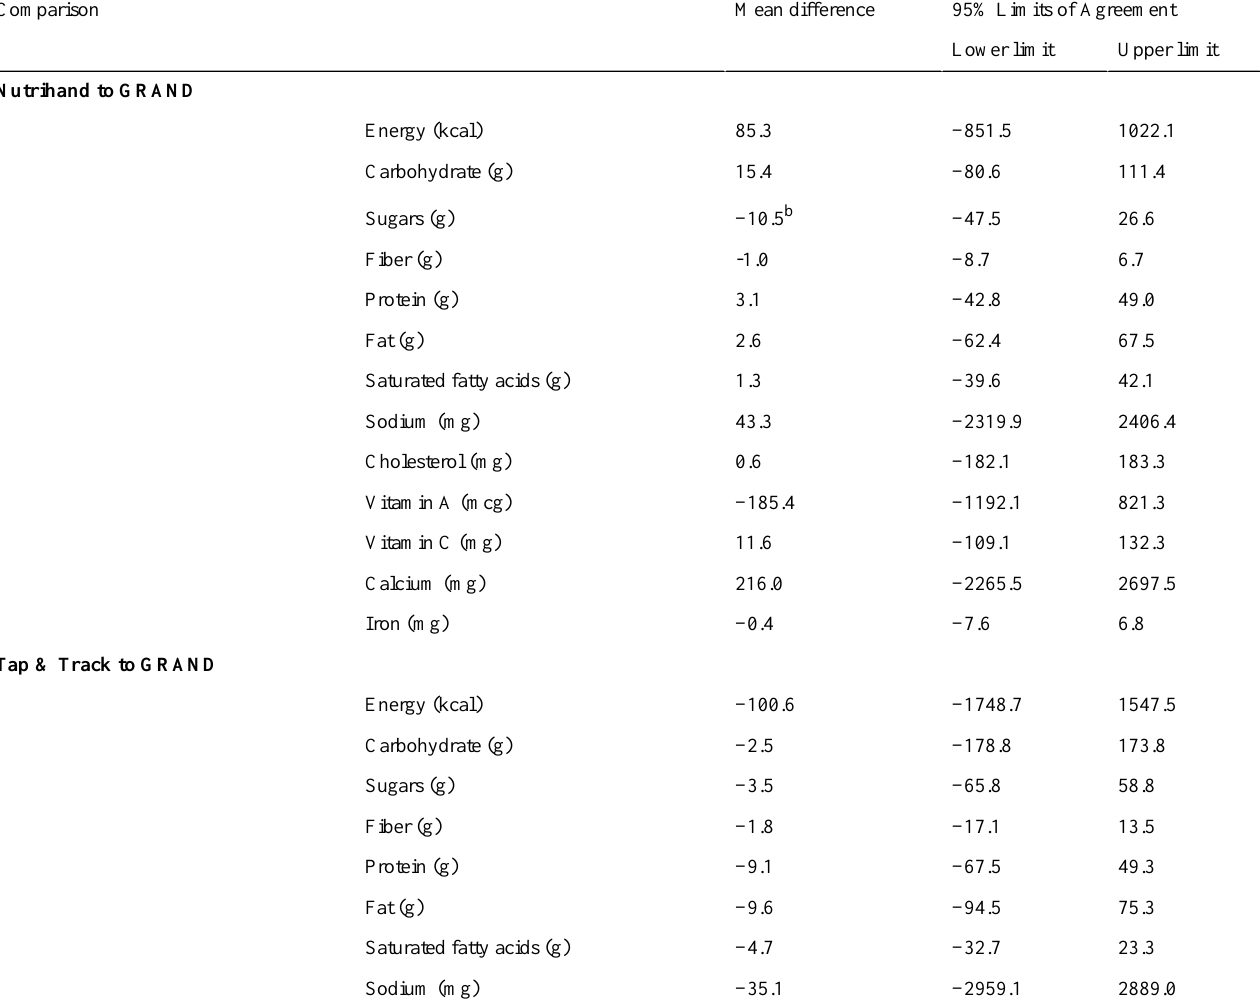
Table 2. Mean difference and limits of agreement a between electronic diet recording (Nutrihand and Tap & Track) and dietitian-entered handwritten records